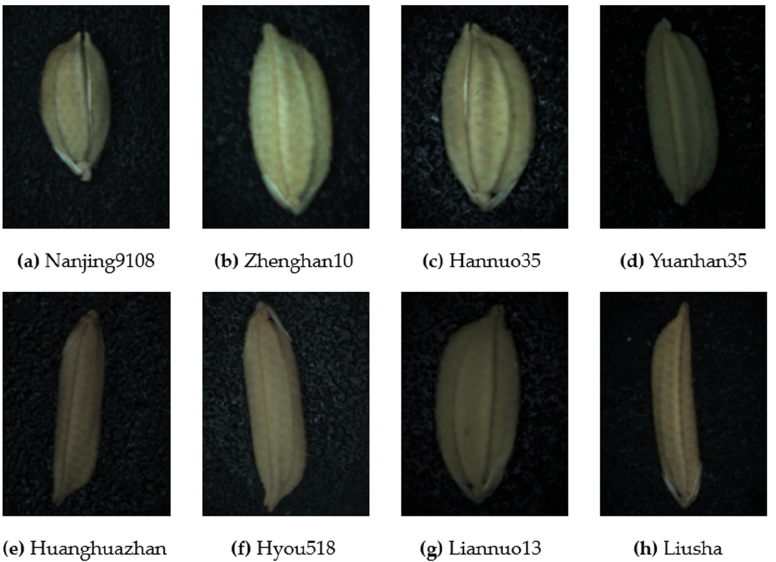
Figure 2. RGB images of the maize seed grains. ( a ) Nanjing9108. ( b ) Zhenghan10. ( c ) Hannuo35. ( d ) Yuanhan35. ( e ) Huanghuazhan. ( f ) Hyou518. ( g ) Liannuo13. ( h ) Liusha.